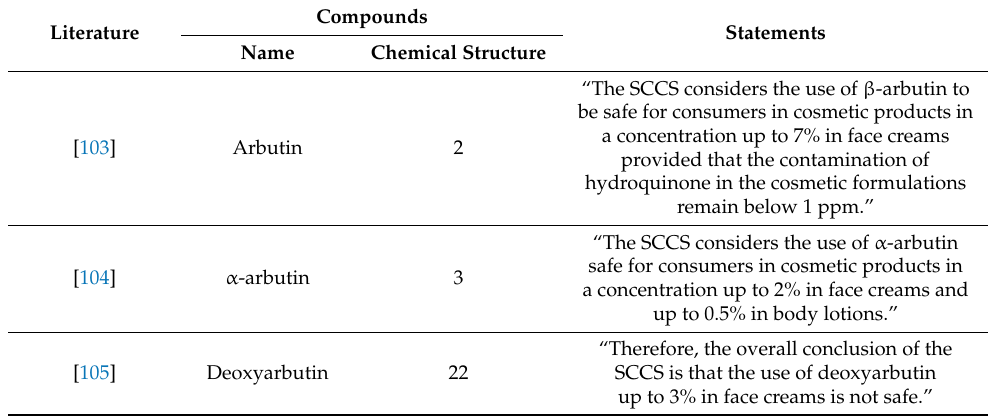
Table 4. Opinion of the scientific committee on consumer safety (SCCS) on the safety of the use of arbutin, α -arbutin, and deoxyarbutin in cosmetic